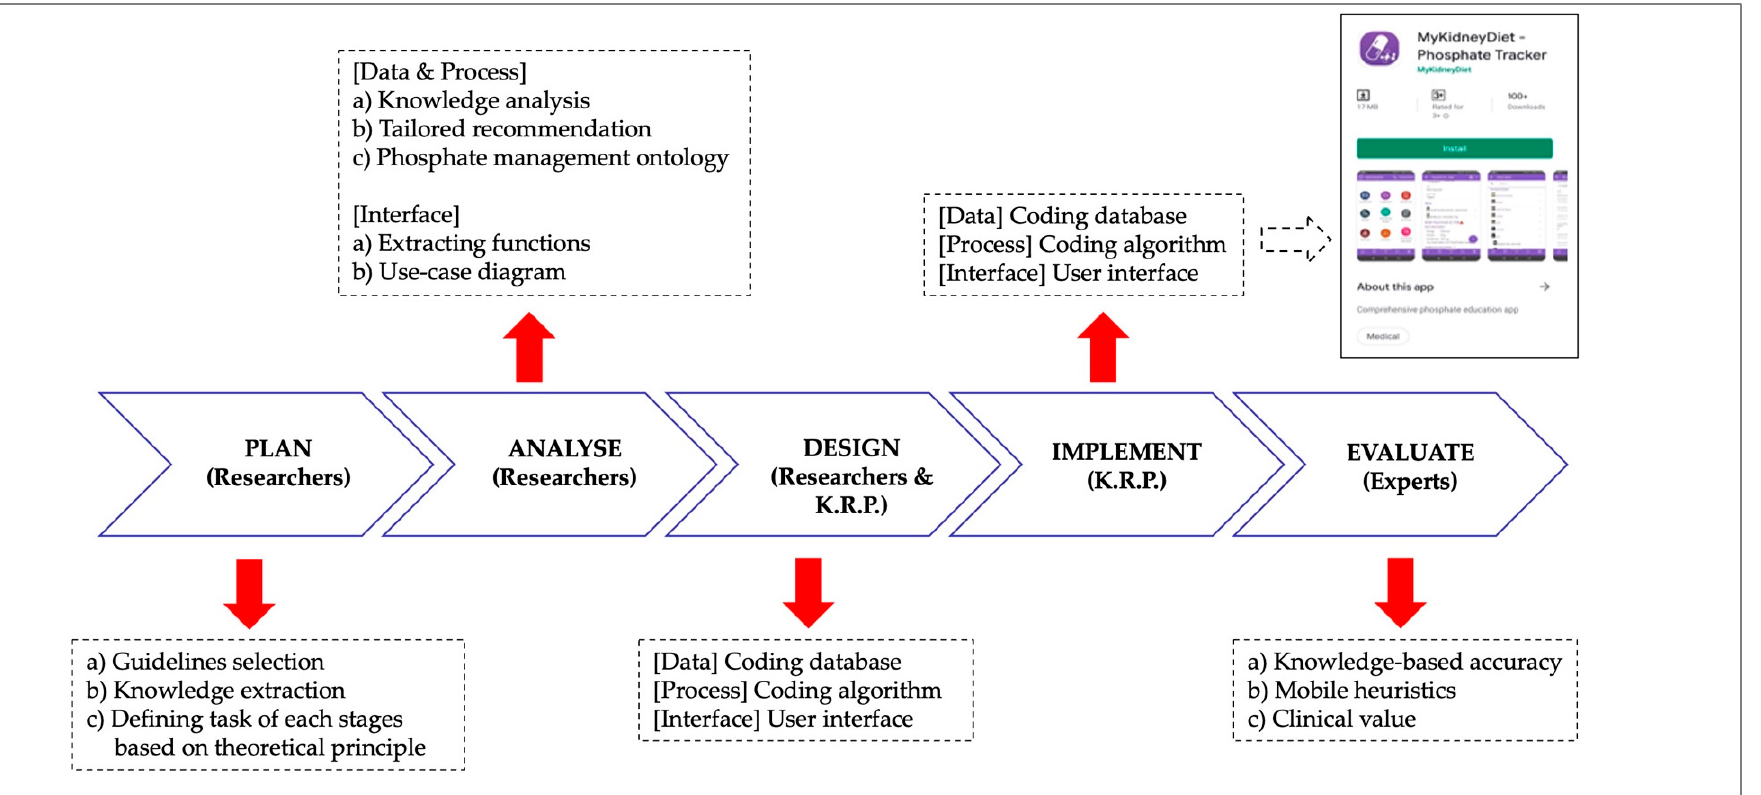
Figure 1. Development of the Phosphate Mobile App. Researchers: T.K., L.F.T., B.H.K., Z.A.M.D., H.M.N., S.S., A.H.A.G., R.Y., B.L.G., S.B., and B.C.B.